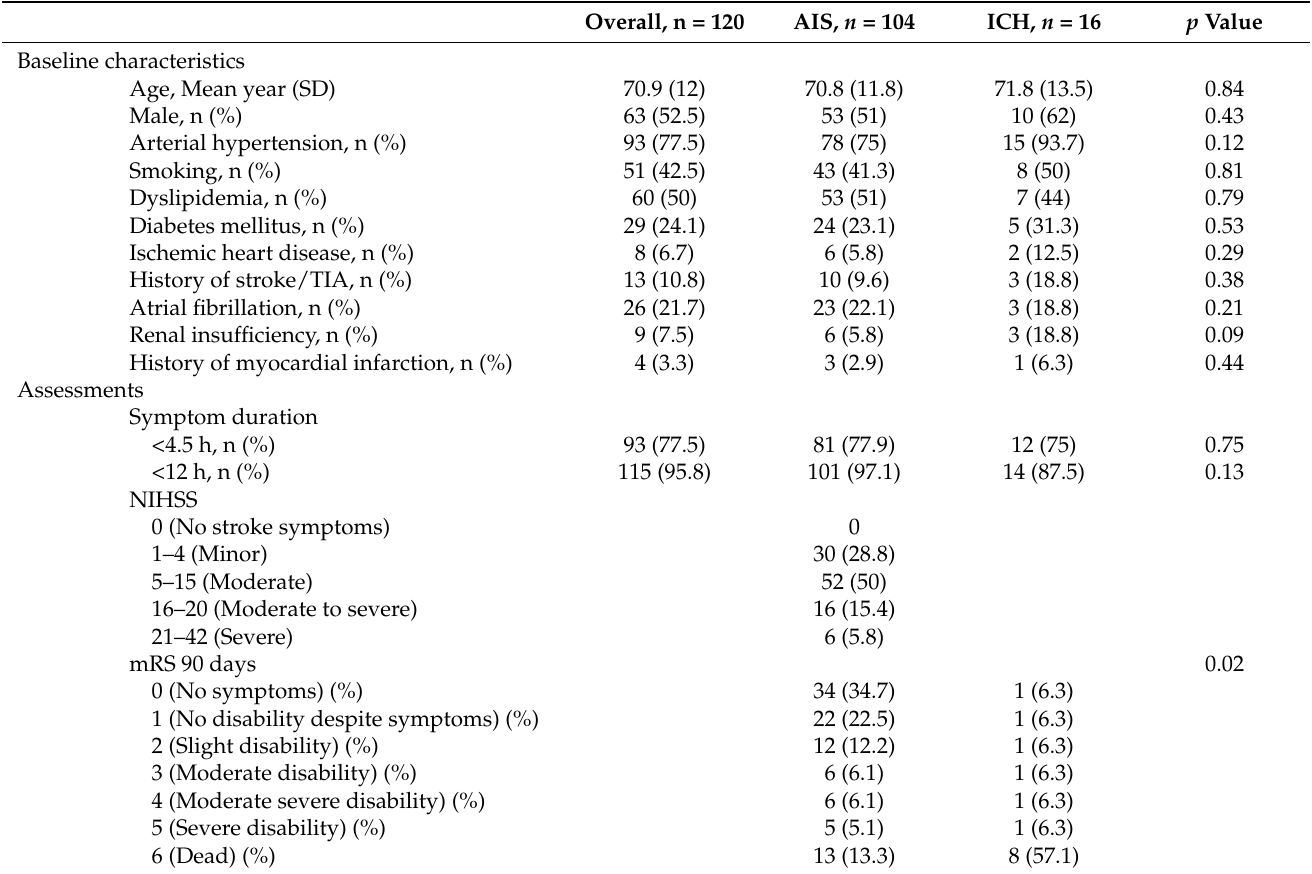
Table 1. Baseline characteristics of 120 included patients with acute cerebrovascular